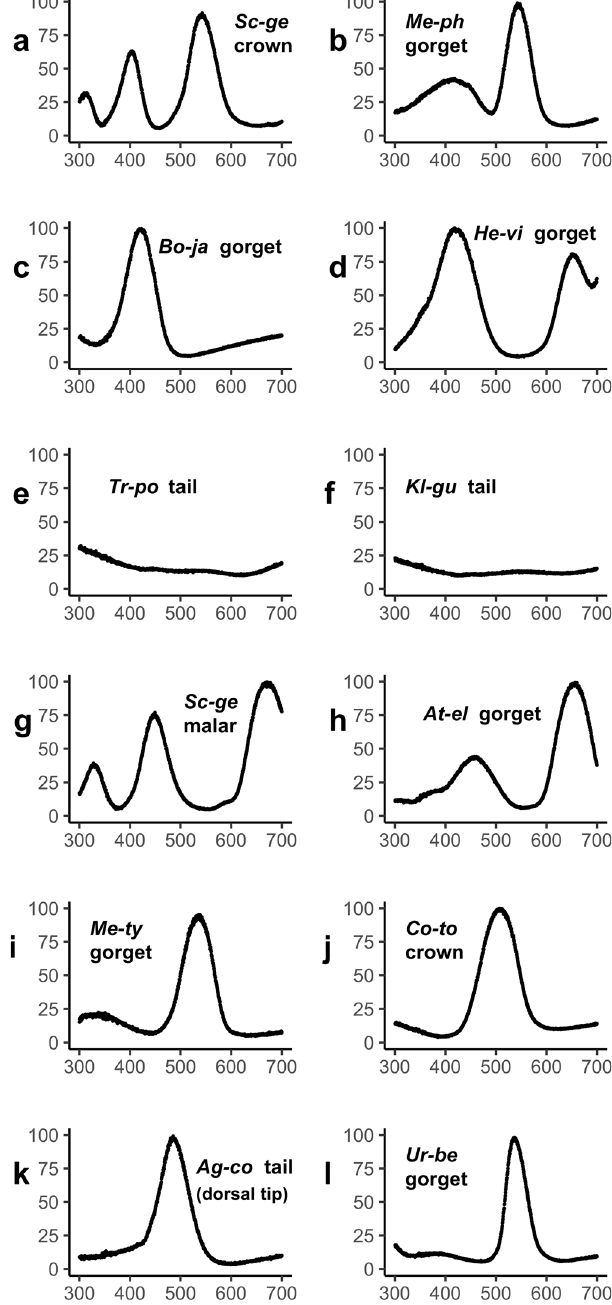
Fig. 4 Examples of unusual and distinctive hummingbird re fl ectance spectra. a , b saturated green + UV re fl ectance, c , d UV saturated re fl ectance, e , f low re fl ectance spectra with unusual UV component, g , h true purple re fl ectance (i.e., s + l ), i , j saturated blue + green ( m + l) re fl ectance, k highly saturated blue, and l highly saturated green (right) spectra. Spectra are labeled with the fi rst two letters of the genus and species names and the patch: a , g Schistes geoffroyi , b Metallura phoebe